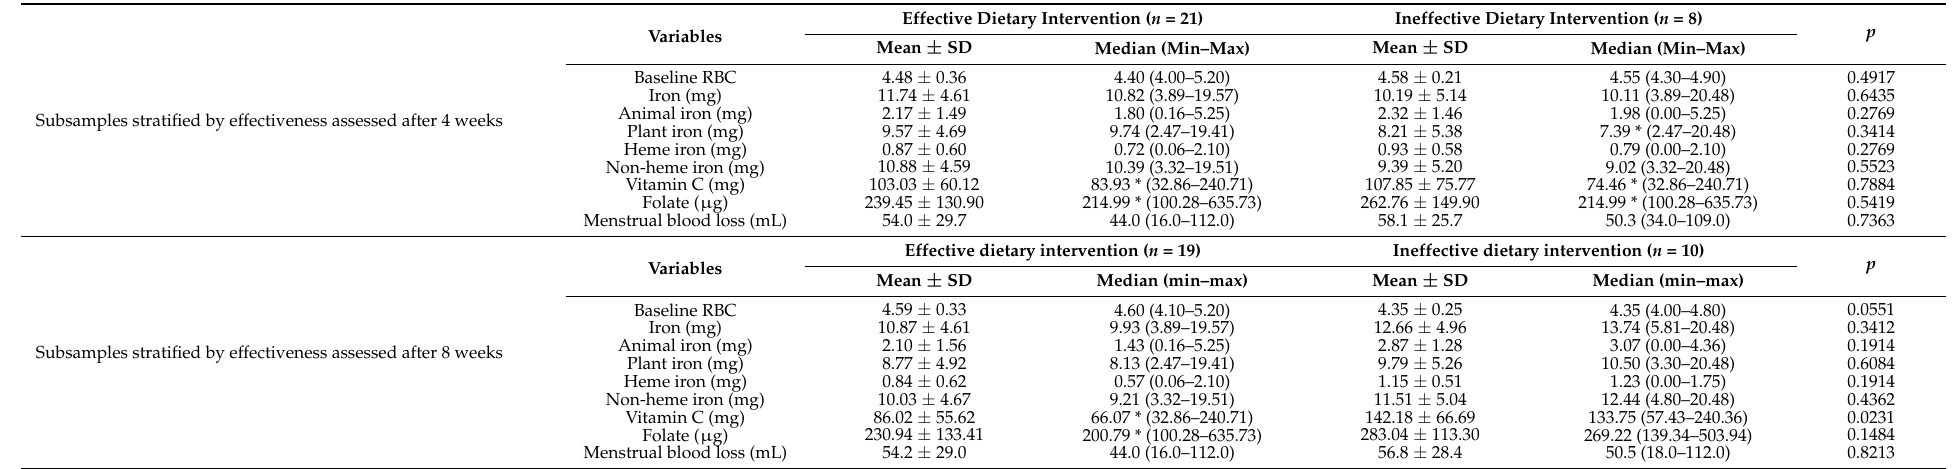
Table 4. The comparison of the baseline characteristics of the subsamples (red blood cells level, dietary intake, and menstrual blood loss) in subsamples stratified by the effectiveness of dietary intervention assessed for red blood cells level after 4 and 8